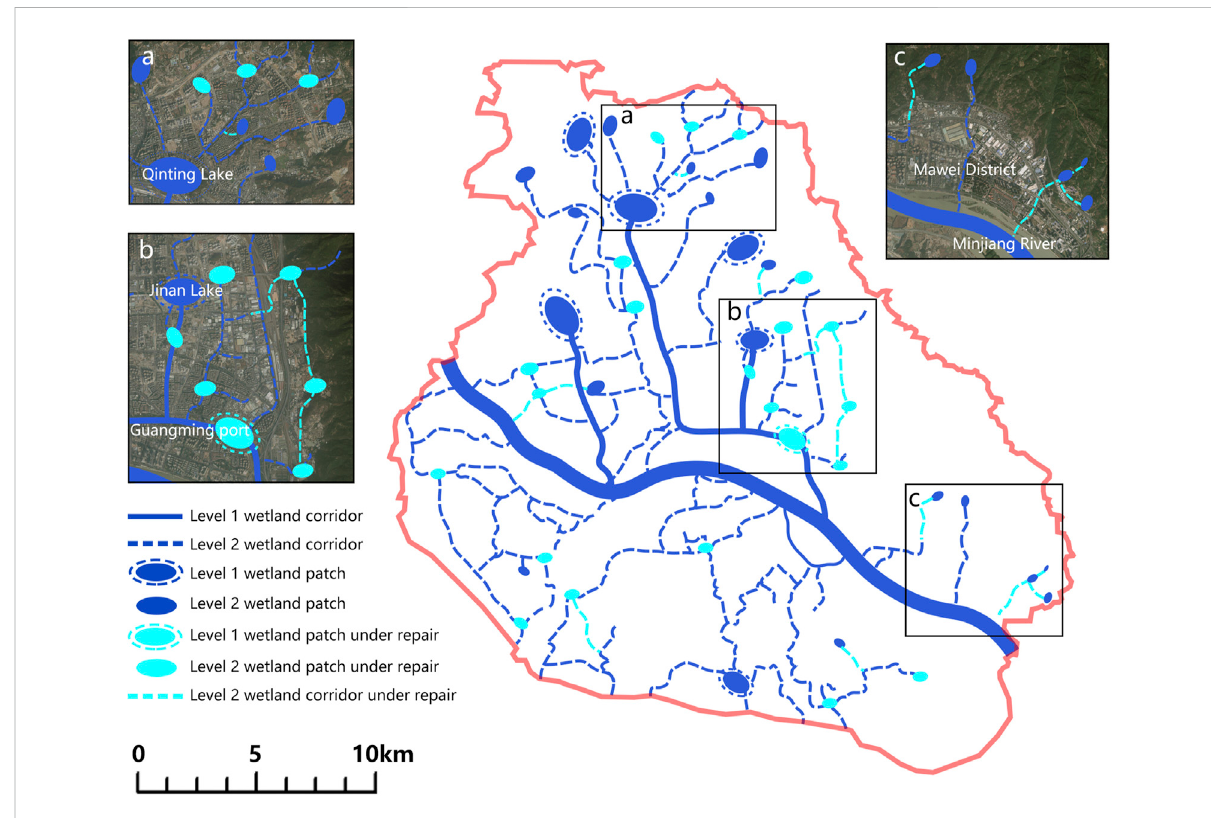
FIGURE 8 Wetland network importance and